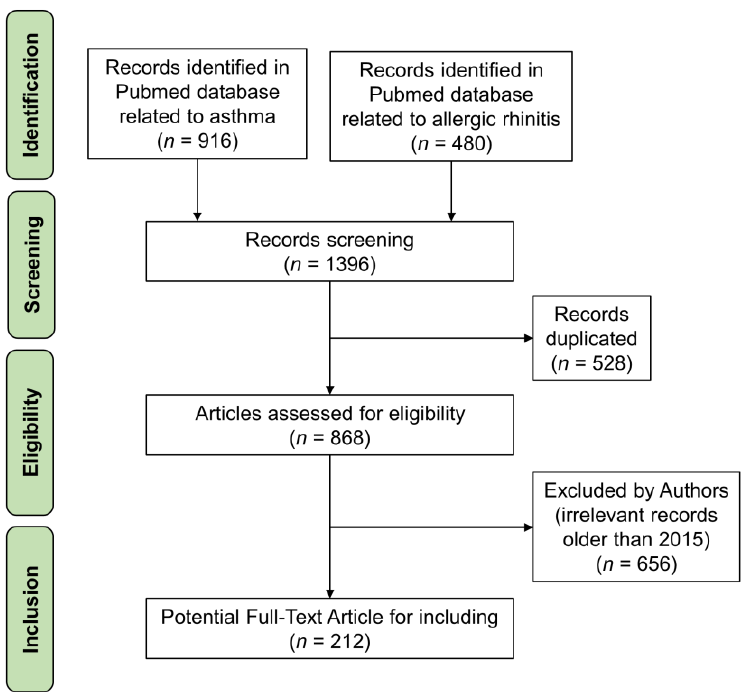
Figure 1. Overview of literature search and the steps performed.